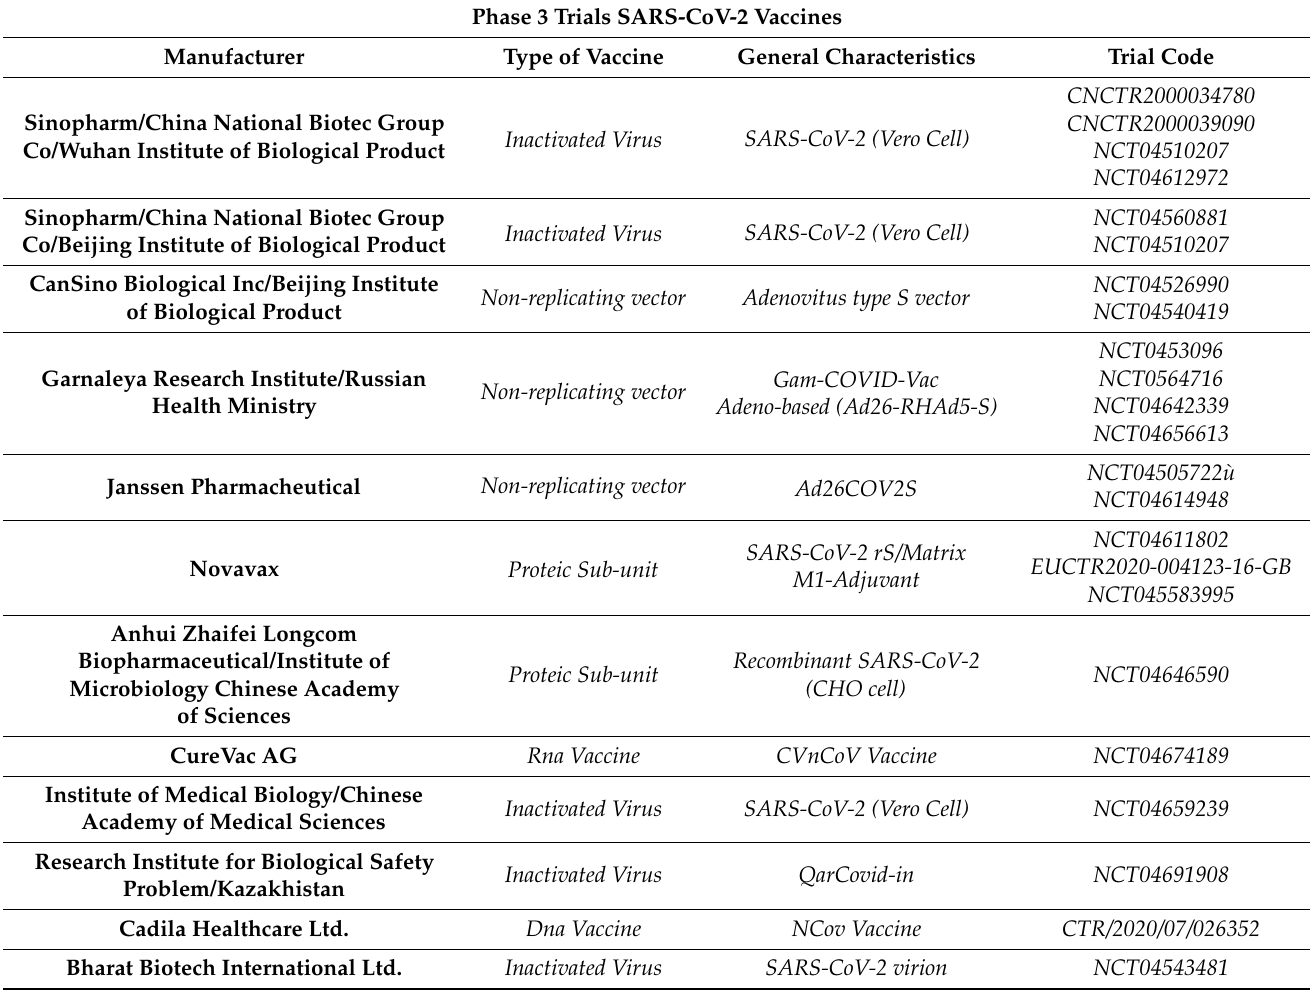
Table 1. SARS-CoV2 vaccines phase 3 trials, for each experimentation [106].